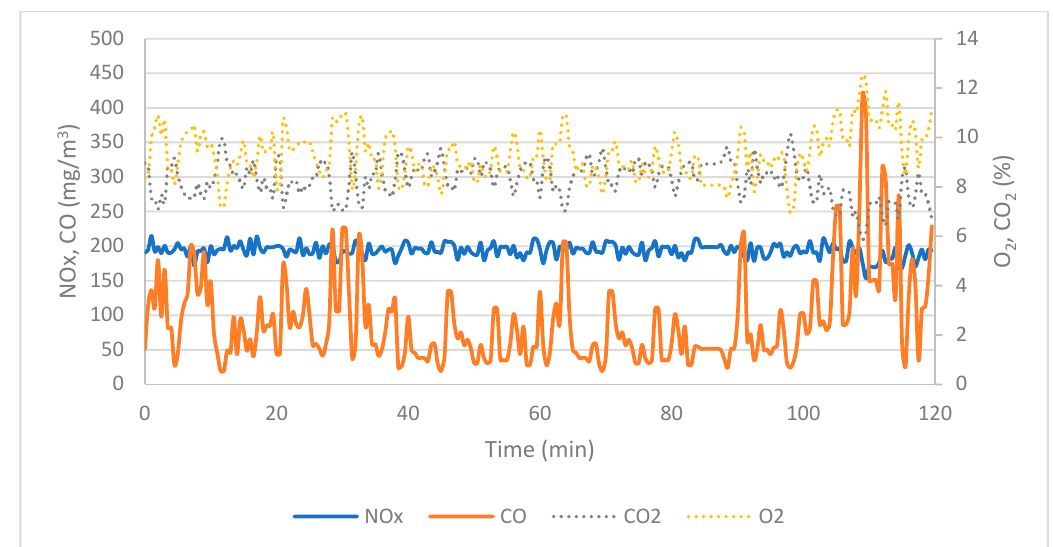
Figure 7 . CO and NOx emissions, oxygen, and carbon dioxide volume in the exhaust gas during combustion of wood pellets, full load.